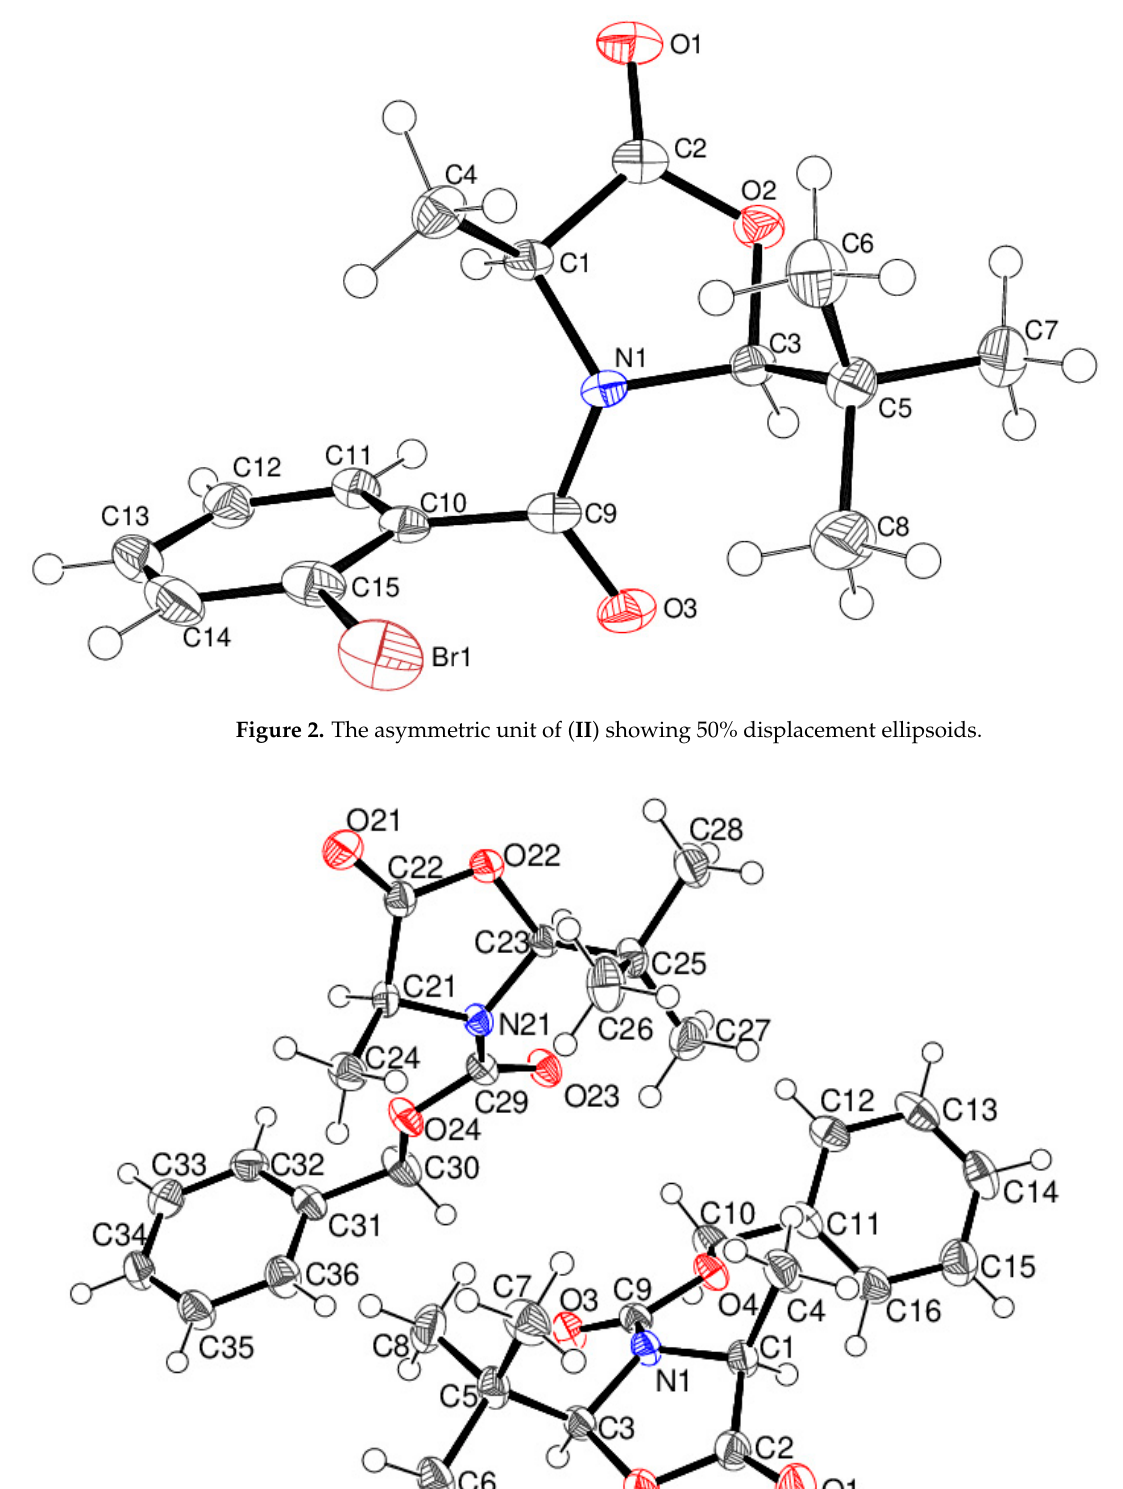
1.313 (3) Å] lie to the same side of the ring and both stereogenic atoms have assumed S configurations. Atoms C1 and O3 are close to anti [C1–N1–C9–O3 = 158.9 (3)°] as are C9 and C11 [C9–O4–C10–C11 = − 164.8 (2)°] and the bond-angle sum for N1 is 349.6°. The dihedral angle between the five-membered ring (all atoms) and the C11–C16 phenyl ring is 36.61 (16)°. In the C21 molecule of ( III ), the C21/C22/O22/C23/N21 five-membered ring is clearly an envelope with the flap atom being O22, which deviates from C21/C22/C23/N21 (r.m.s. deviation = 0.003 Å) by − 0.129 (4) Å with Q (2) = 0.085 (3) Å and φ (2) = 5 (2)° (pivot atom O2); the torsion angles around the ring are shown in Table 1. The atoms C21 and O23 are close to anti [C21–N21–C29–O23 = 158.8 (3)°] as are C29 and C31 [C29–O24–C30–C31 = − 172.44 (2)°] and the N21 bond-angle sum is 348.4°. The dihedral angle between the five- membered ring (all atoms) and the C31–C36 phenyl ring of 72.32 (15)° is very different to that in the C1 molecule, which can be seen in an overlay plot (Figure 4) generated with QMOL [20].